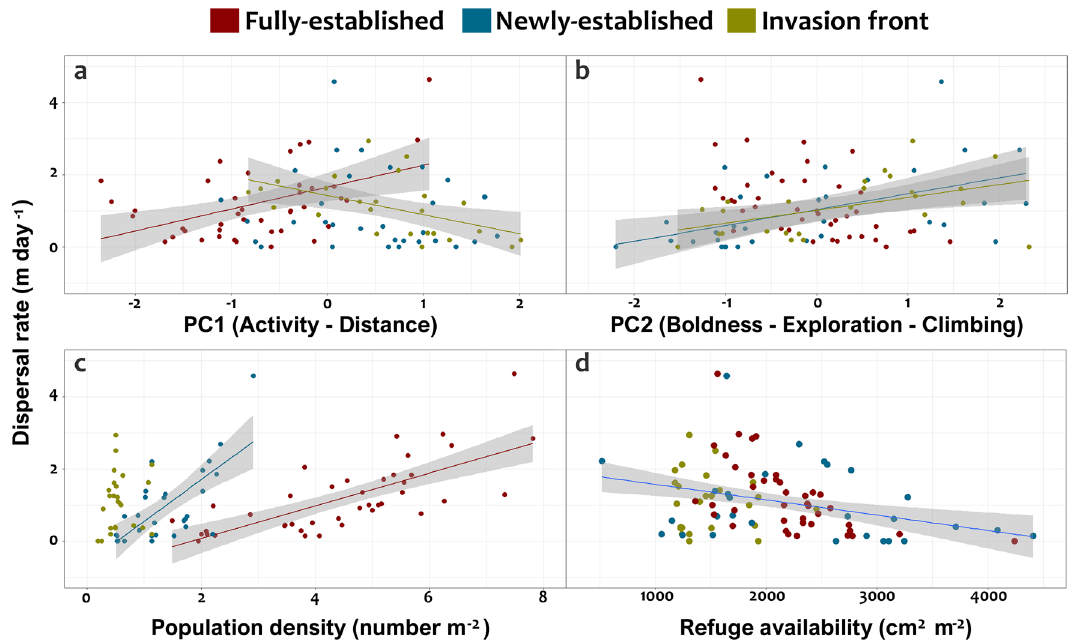
Figure 3. Relationships of behavioural traits, population density and refuge availability to dispersal rate in signal crayfish. Behavioural traits are based on PCA scores whereas mean density and mean refuge represent the average values of crayfish density and refuge of sections traversed during dispersal. Significant relationships (trend lines) and 95% CI are shown.